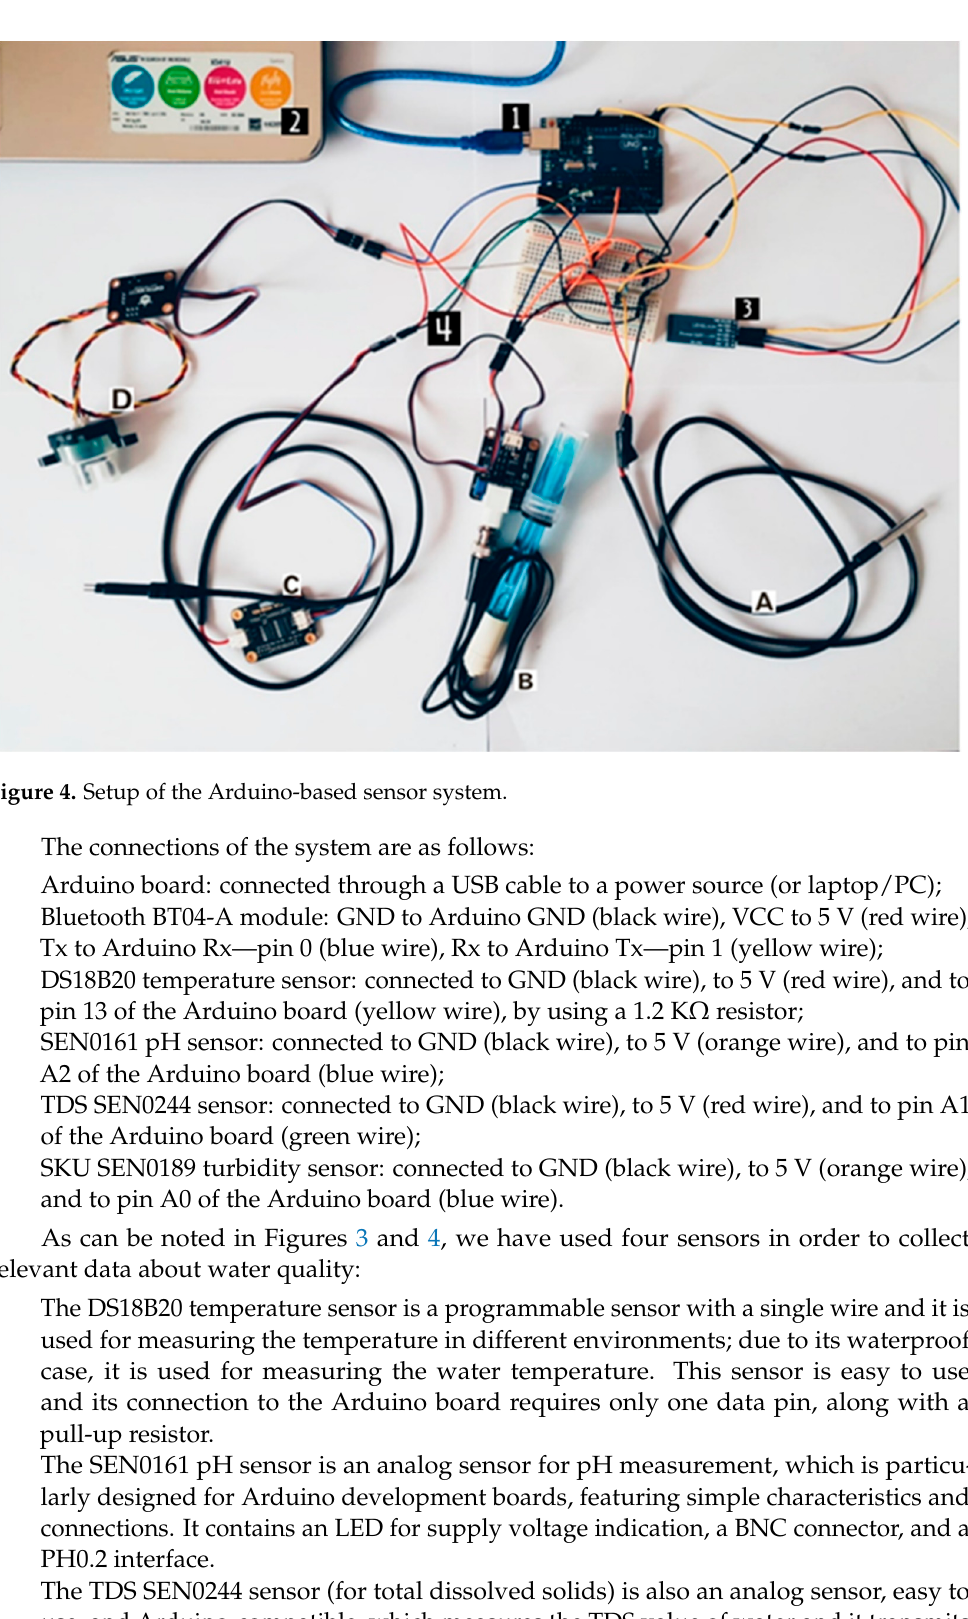
Figure 3. The hardware architecture of the water status project.